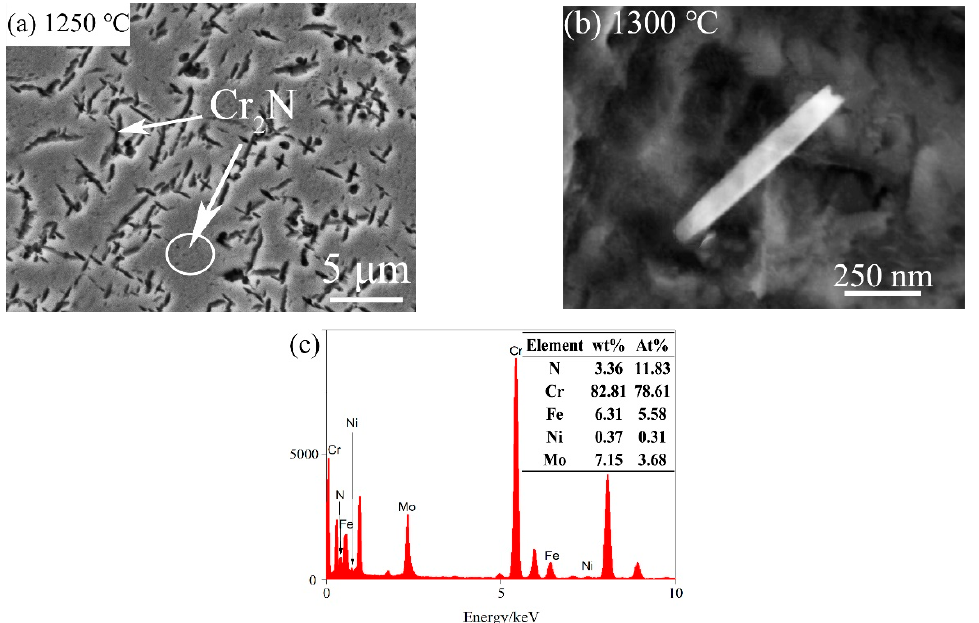
Figure 10. SEM and transmission electron microscopy (TEM) micrograph of Cr 2 N. ( a ) SEM image; ( b ) TEM image; ( c ) energy dispersive spectroscopy (EDS) of Cr 2 N.